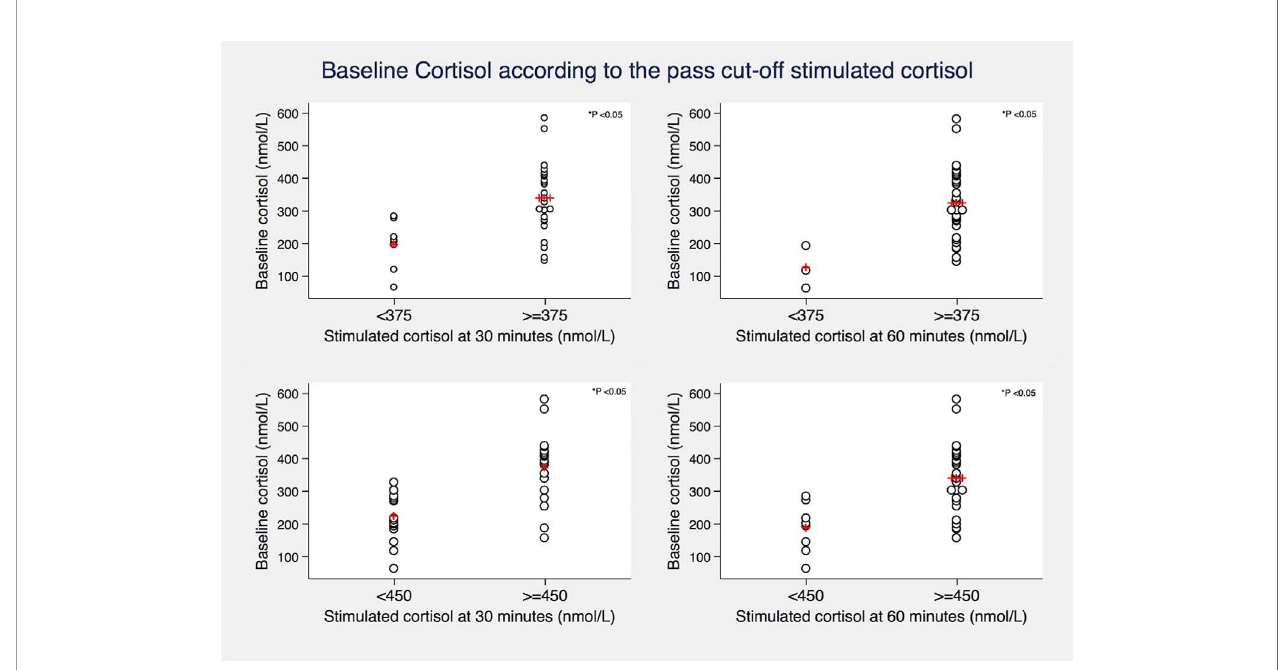
FIGURE 1 | Relationship between baseline cortisol levels and different synacthen-stimulated cortisol cut-offs (375 and 450 nmol/L) at 30 and 60 minutes. Red crosses represent mean values. P value derived from Two-sample T-test.